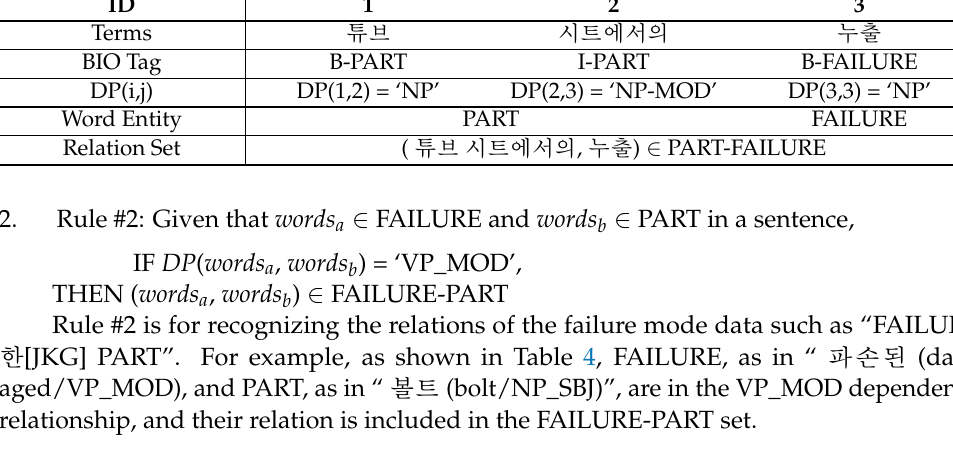
Table 4. An example of the results by applying Rule #2.